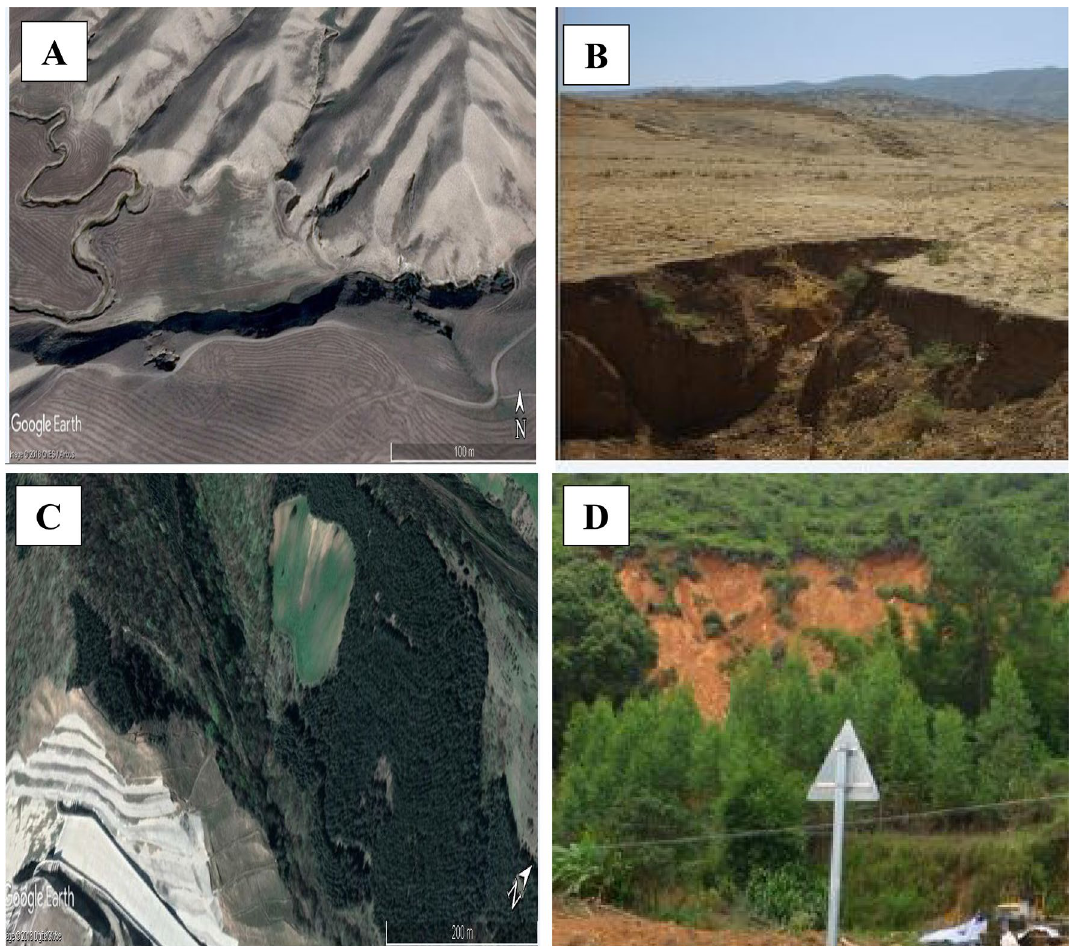
Figure 2. Some examples of gully erosion (a, b) and landslides (c, d) in the Golestan Province, Iran. *( A ) and ( C ) were obtained from Google Earth, and ( B ) and ( D ) were taken by Narges flood, landslides, and gully erosion susceptibility maps to prepare a multi-hazard probability map for land use planning and hazard mitigation. Landslides, gully erosion, and flood inventory mapping. A key step for susceptibility mapping is the preparation of an inventory of hazard landforms 81 . The landslide, gully erosion, and flood inventory for the Gor- ganrood Watershed were compiled from field investigation and national and regional documents from various organizations including the Water Resources Organization and Department of Natural Resources Management of Golestan. Considering that some hazard locations are located in mountainous areas and the field investigation may miss them, Google Earth images were used for landslides identification, as well. The inventory map for gully erosion is a collection of occurrences (283 gully locations), where a landslide inventory map is containing 351 landslide locations. Some authors highlighted that using analysis of the past documents of flood occurrences, the future flood events in an area can be estimated 82 . So, in this study, a flood inventory map was prepared by containing 127 flood locations. In general, a random partition algorithm 83,84 was used to separate training points from the validation points. In the current study, 70% of each hazard was used in the model building (training) and the remaining 30% were used for the validation. Three replications and three sample data sets were used to perform these processes including S1, S2, and S3. These datasets were arranged to evaluate the robustness of the built models and data sensitivity 81,85,86 . The equal data sets (positives/negatives) are applied which includes all the positive cells (hazard locations) and the same randomly inferred negative cells (non-hazard locations).